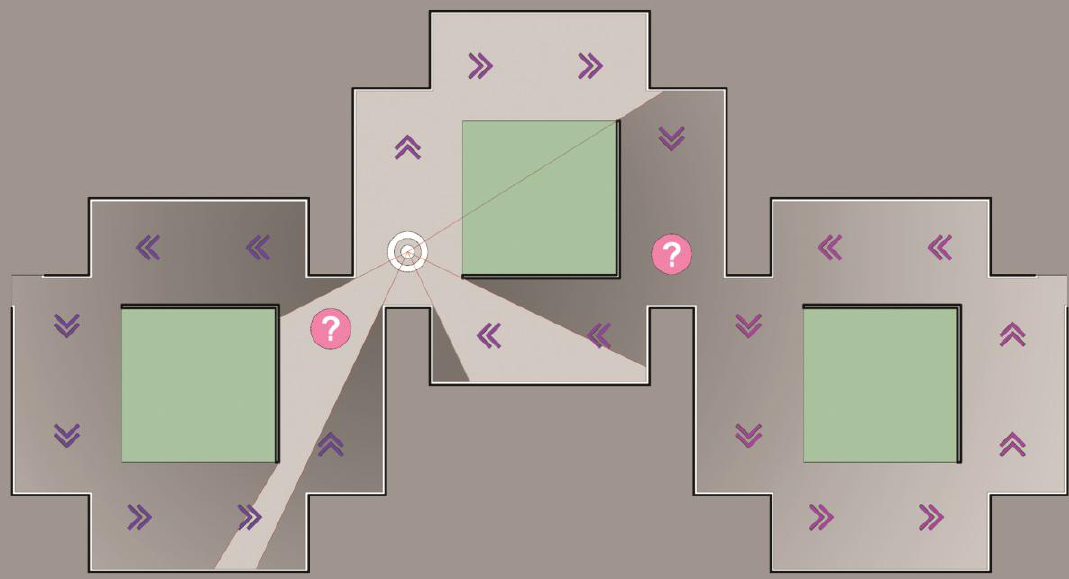
Figure 4. The scenography of the rooms is arranged in such a way as to limit the visitor’s visibility (white dot in the image). This allows to load only part of the works in the room, those contained in the visual